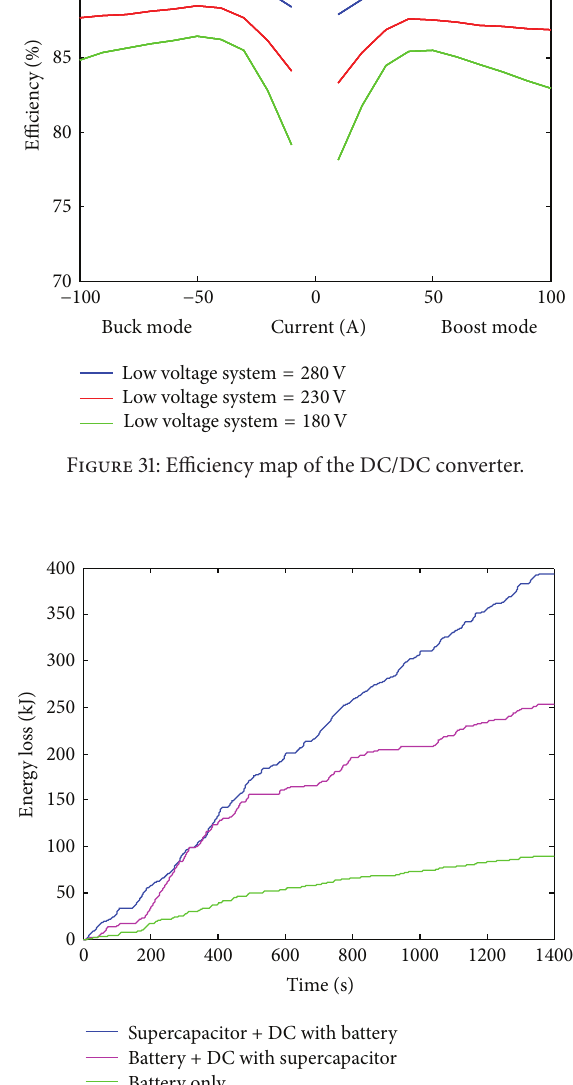
Figure 34: Energy loss of the semiactive topological structure described in Figure 3 for UDDS driving